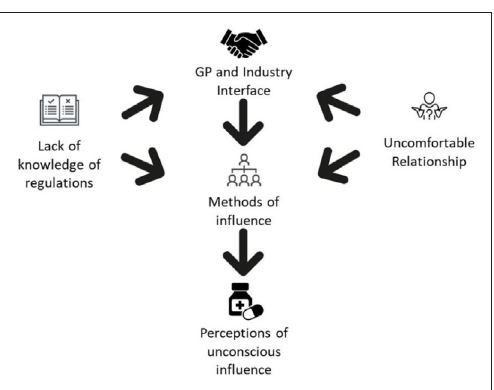
Figure 1 Relationships between